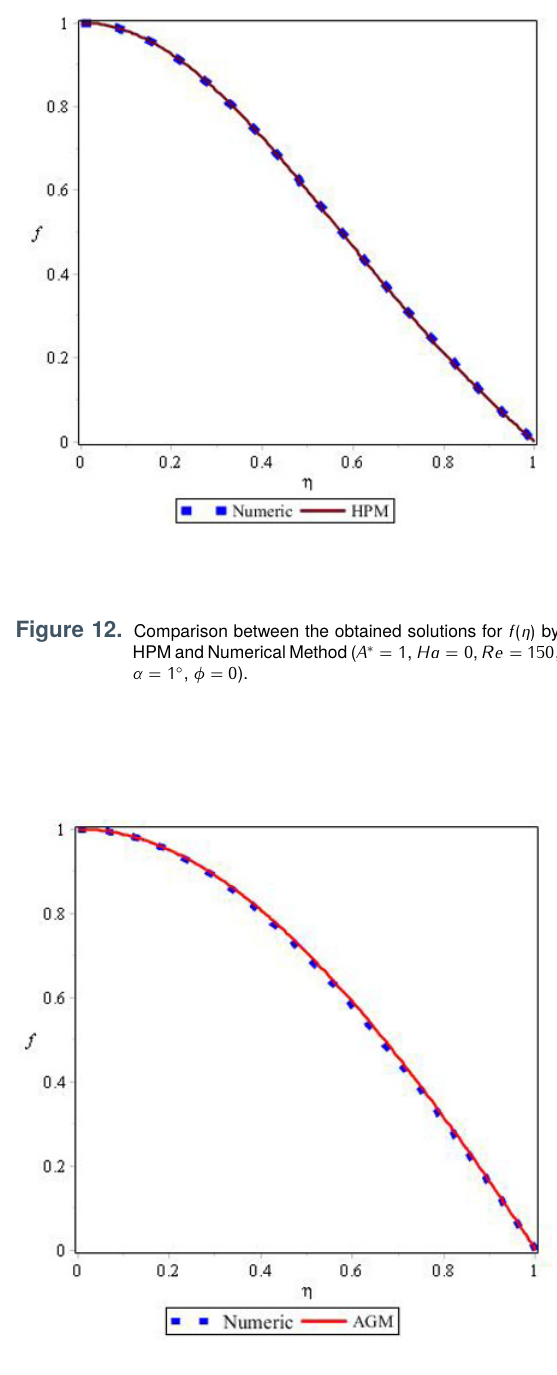
Figure 11. Comparison between the obtained solutions for f AGMandNumericalMethod( A ∗ = 1 , Ha = 0 , Re = 150 , α = 1 ◦ , φ = 0 ).